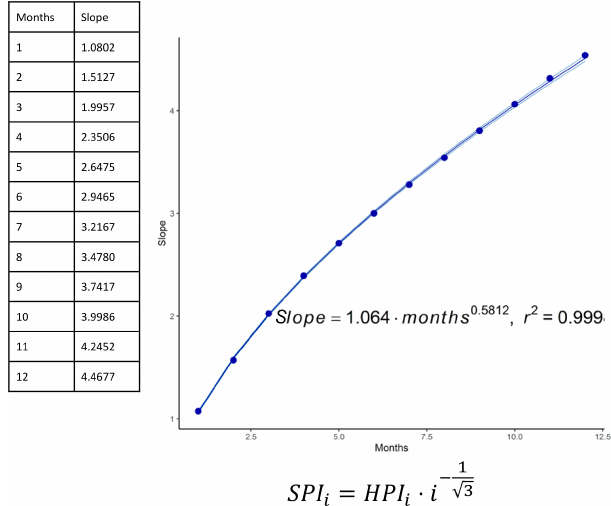
Figure 5. Duration and scale factors of the relationship between SPI and HPI for a duration of 1 to 12months.